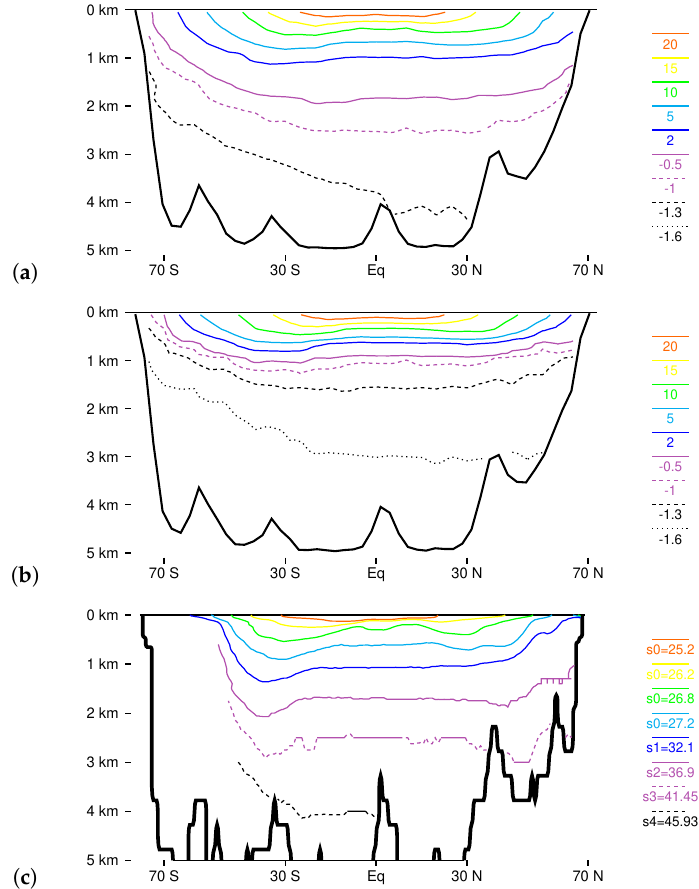
Figure 8. Stratification along 30 ◦ W. ( a ) Temperature ( ◦ C) in the simulation with mixing. ( b ) Temperature ( ◦ C) in the simulation without mixing. ( c ) Potential density in nature, with the upper four isopycals referenced to the surface, and the lower four isopycnals referenced to their approximate depths. The lower isopycnals are shown only in the vicinity of the depth to which they are